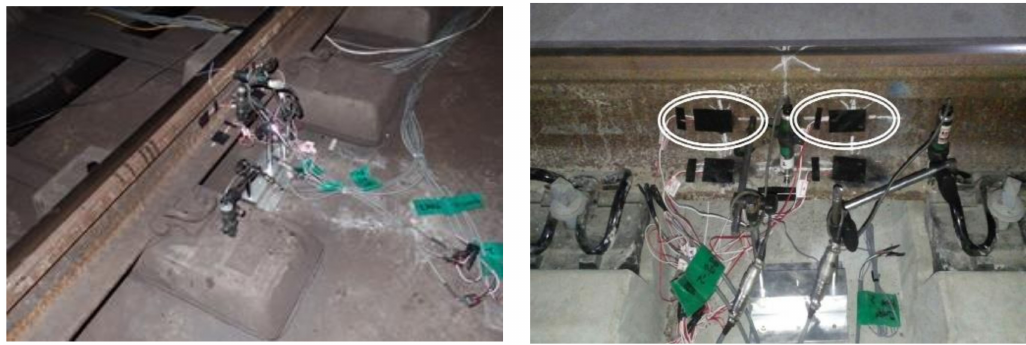
Figure 4. Photograph of typical field measurement on track.